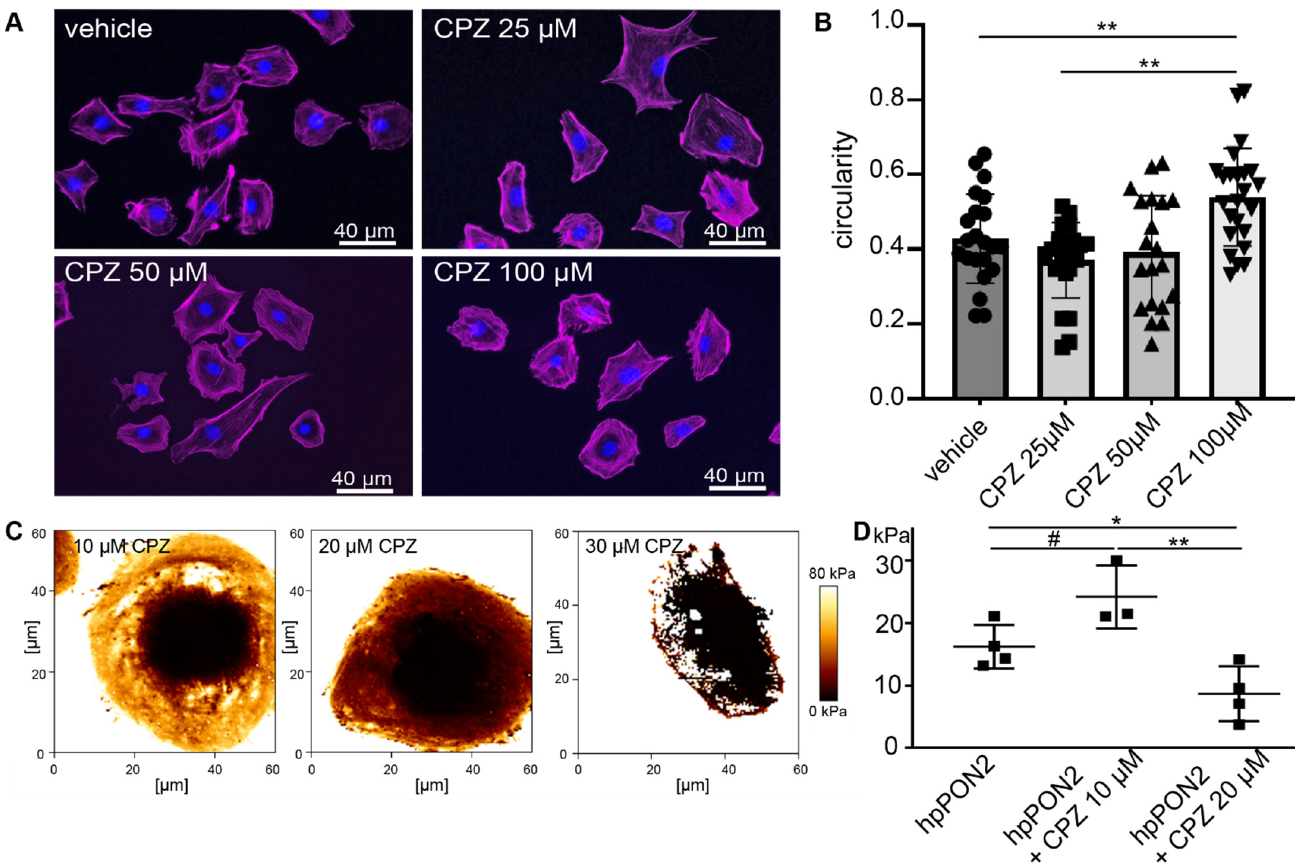
Figure 2. Capsazepine treatment reverses effects of PON2 deficiency. Phalloidin staining of stable podocyte cell lines expressing shPON2 after treatment with varying doses as indicated ( A ). Capsazepine (CPZ) treatment results in the reorganization of the actin cytoskeleton and a reversion to round morphology. Quantification of circularity of cells employing Fiji software (means 0.43; 0.37; 0.54 for vehicle, 25 µM, and 100µM, respectively; ** p < 0.01) ( B ). Representative images of Young’s Modulus maps of PON2-proficient and PON2-deficient podocytes after treatment with capsazepine ( C ). Cortical stiffness is reduced in a dose dependent effect (means: vehicle 16.26 kPa; 10µM CPZ: 24.23 kPa; 20 µM CPZ: 8.67 kPa; * p < 0.05; ** p < 0.01; # = ns) ( D ).